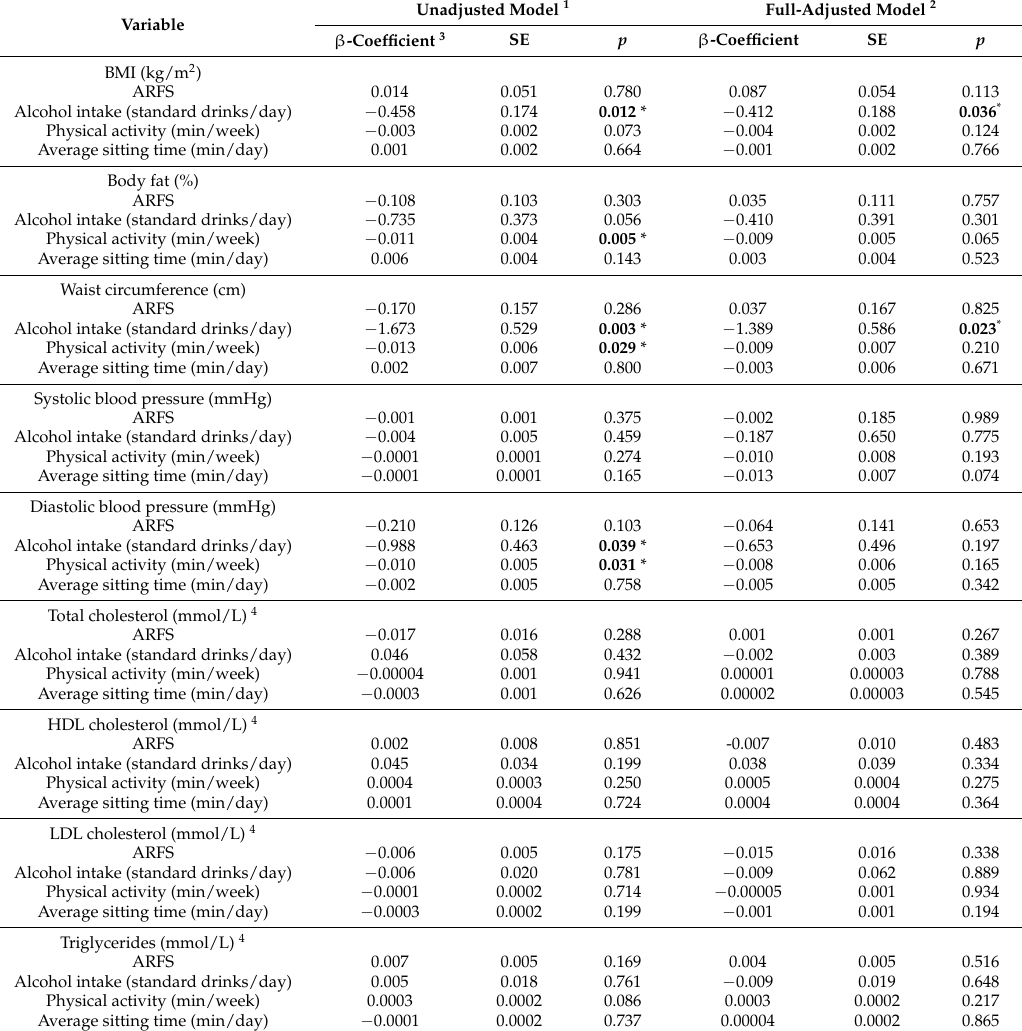
Table 2. Linear regression analysis results of lifestyle behaviours with CVD risk markers in